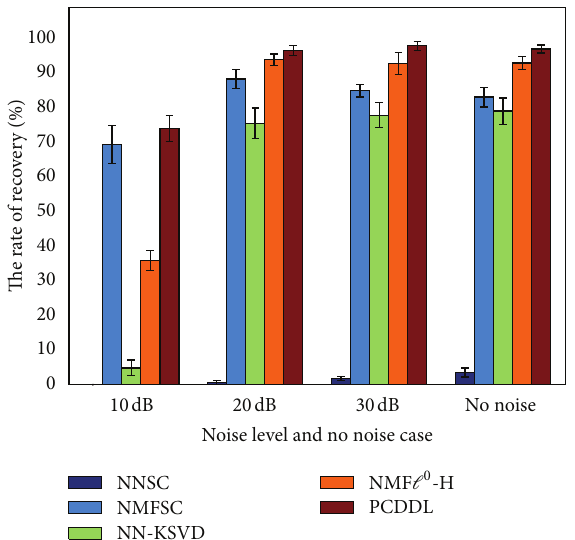
Figure 5: Results of a synthetic experiment with a decimal digits dictionary of size 64 × 90. For each of the tested algorithms and for eachnoiselevel,10trialswereperformed.Averagedvaluesoflearned atoms and corresponding deviation values are